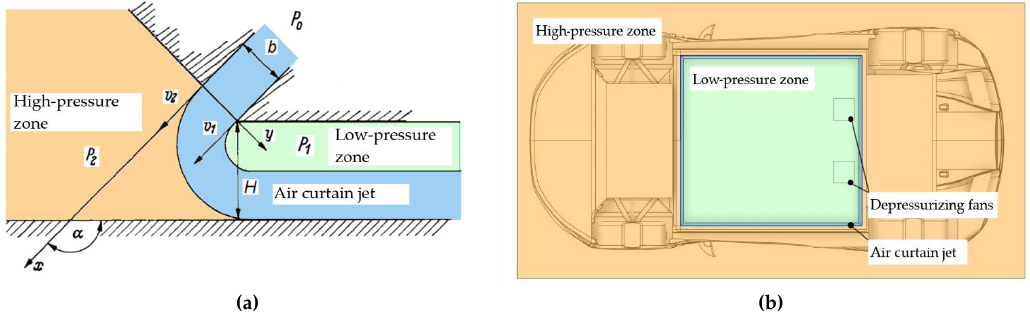
Figure 1. Air curtains: ( a ) schematic diagram; ( b ) sample placement under a vehicle.